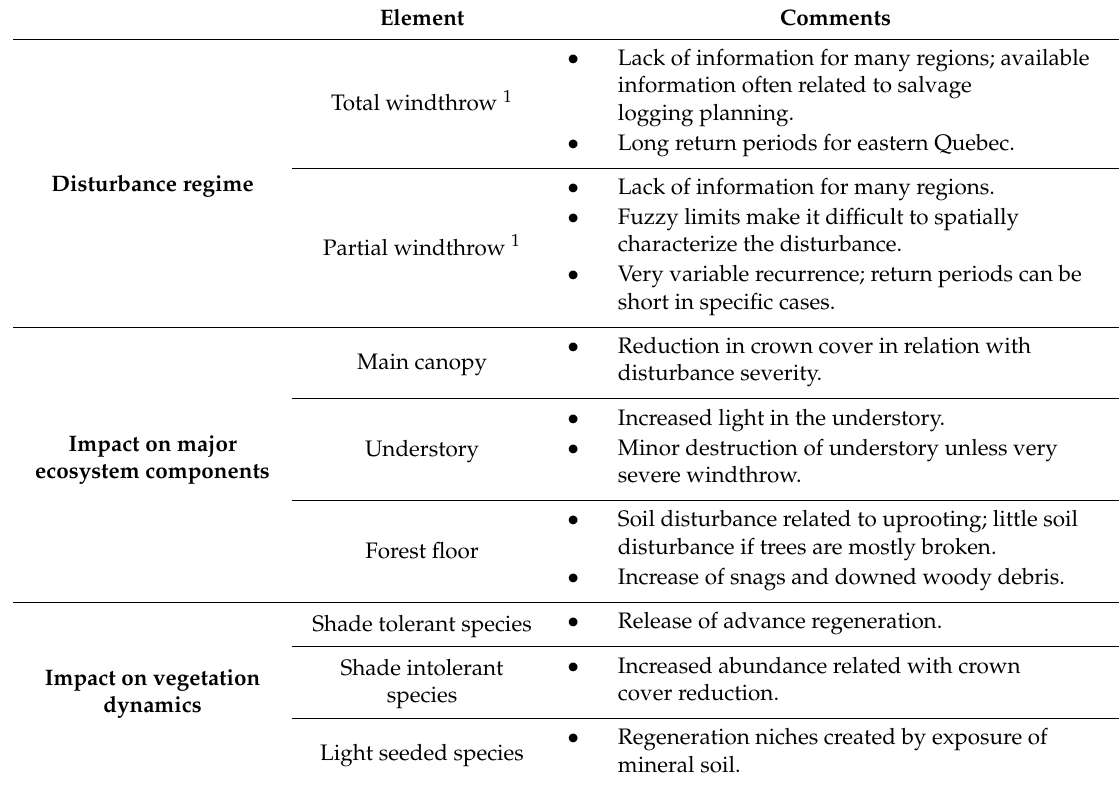
Table 2. Key elements of wind disturbance to guide forest ecosystem